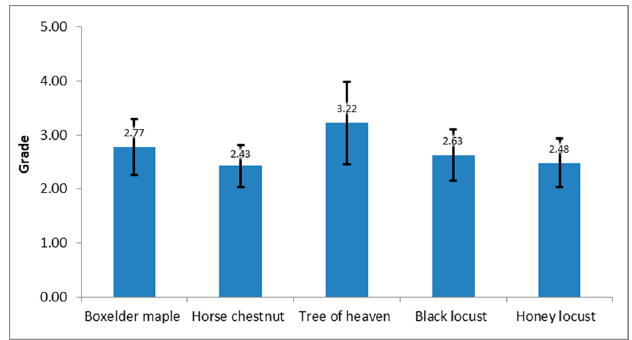
Figure 8. Average surface quality grades with standard deviations after turning. Table 6. Statistical difference of the turning surface quality grades between different tree species expressed by the p -value of the ANOVA analysis. The values in bold indicate a significant difference.